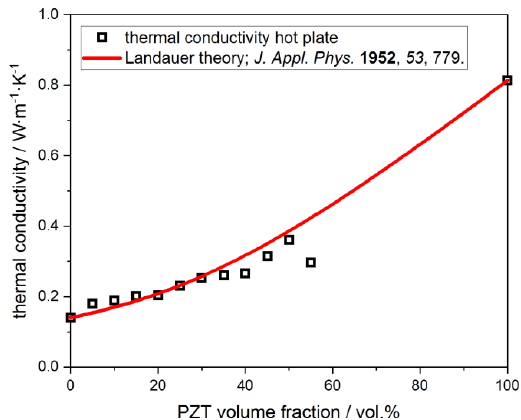
Figure 7. Experimental thermal conductivity (hot plate technique) of PZT-polymer composites cured at 200 °C as a function of the filler content. The observed data (□) fits well to the values extrapolated by the Landauer theory (red line).